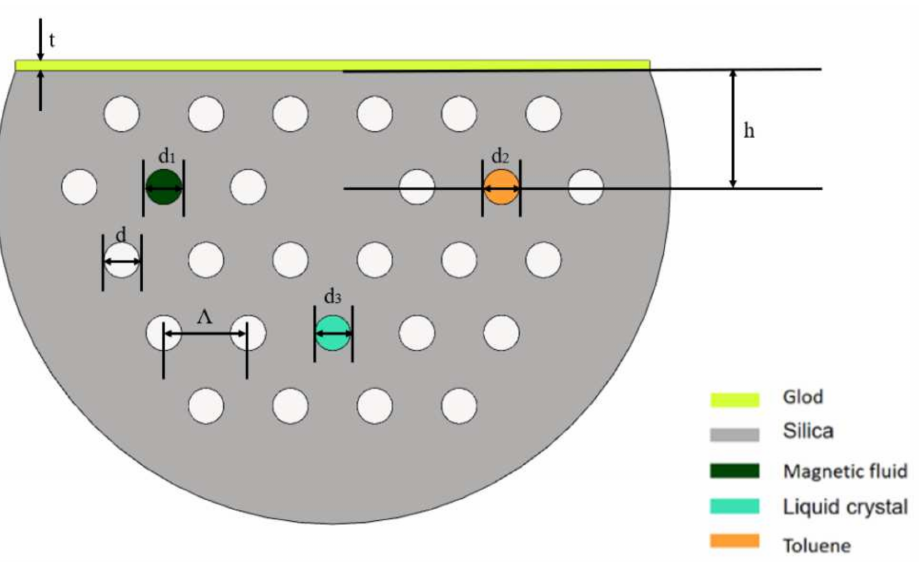
Figure 1. Structure diagram of the selectively filled D-shaped